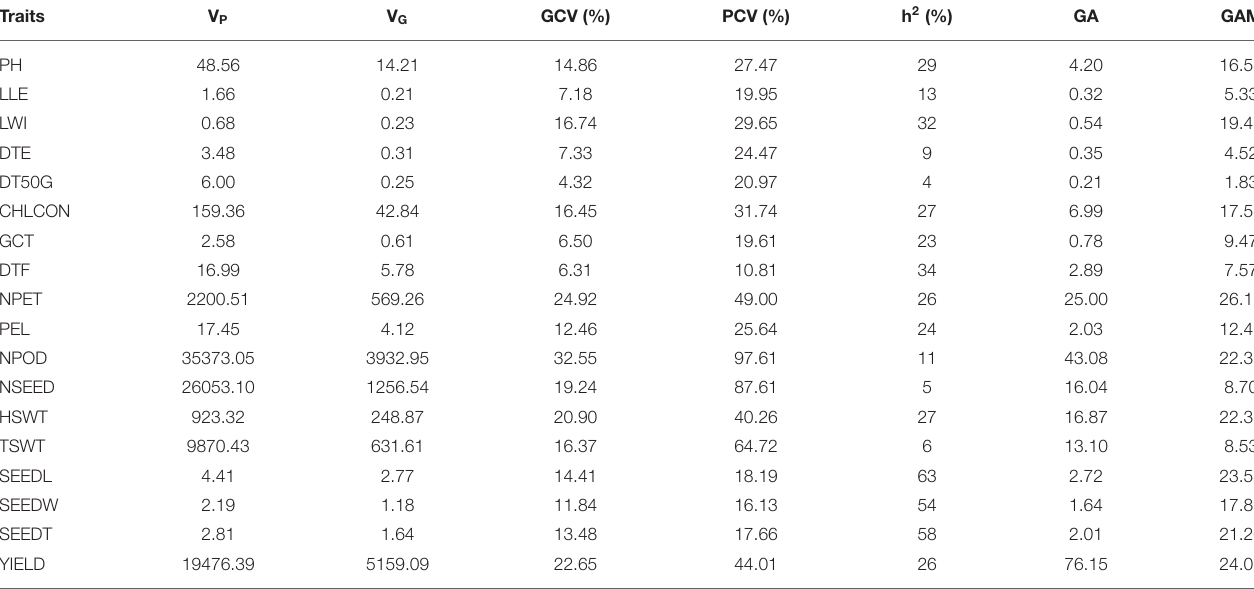
TABLE 7 | Variance components, heritability, and genetic advance for growth and yield traits.